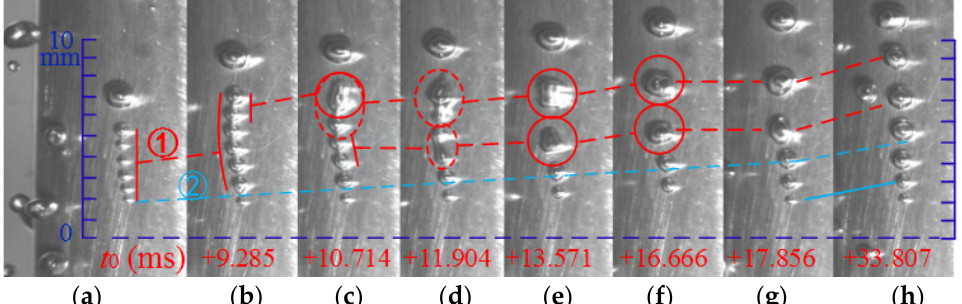
Figure 2. The amalgamation process of beaded bubbles in open space. time ( a ) t 0 ms, ( b ) t 0 + 9.285, ( c ) t 0 + 10.714, ( d ) t 0 + 11.904, ( e ) t 0 + 13.571, ( f ) t 0 + 16.666, ( g ) t 0 + 17.856, ( h ) t 0 + 33.807.